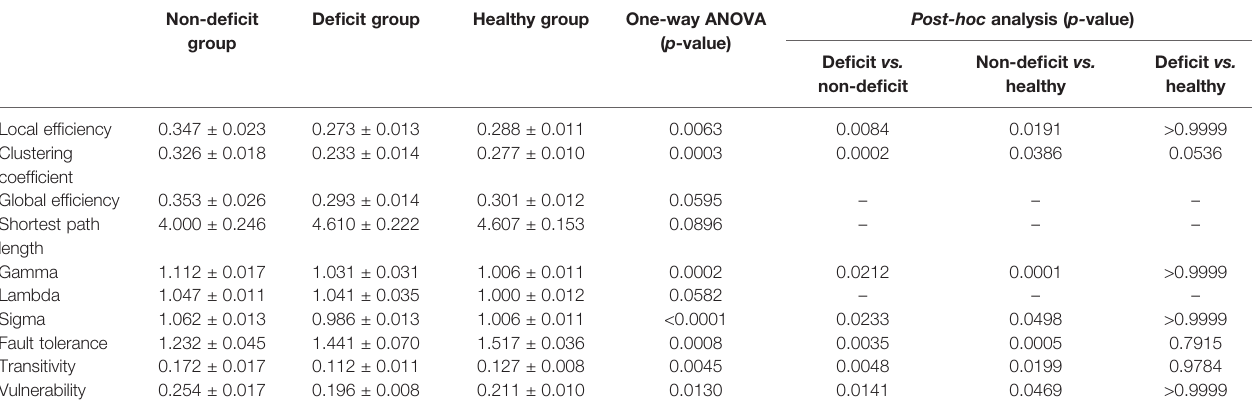
TABLE 3 | Global properties compared between the patient and healthy groups for tumors located on the right